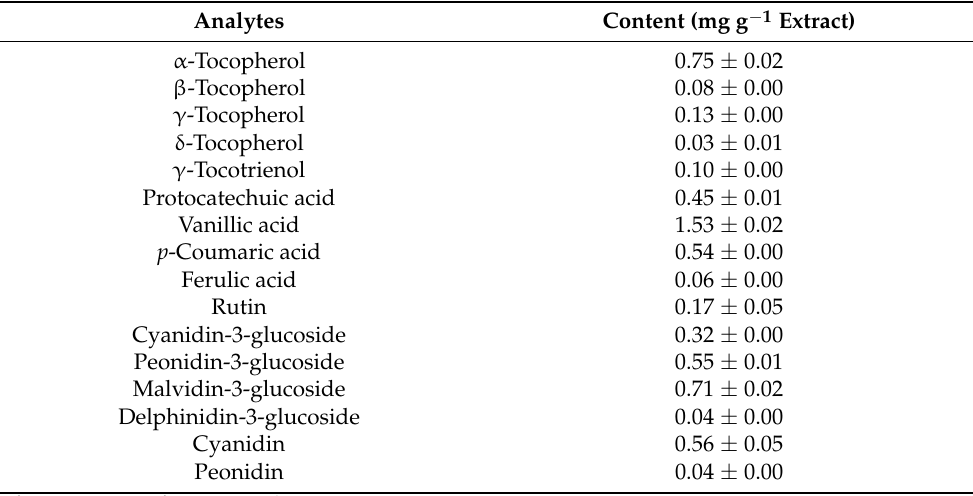
Table 1. Chemical constituents of purple rice husk extract